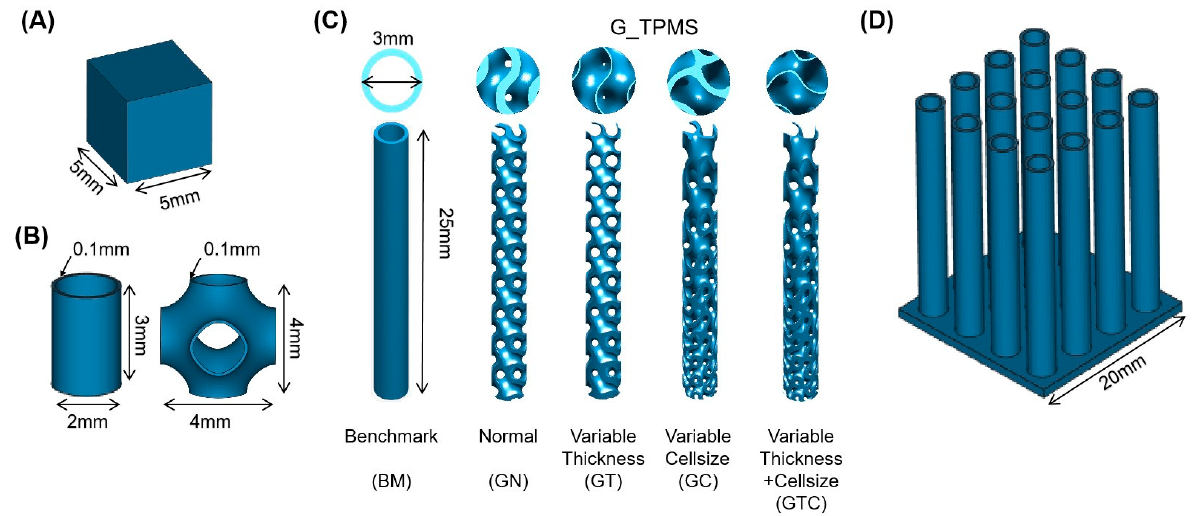
Figure 1. Design models: ( A ) 5 × 5 × 5 mm 3 cube for energy density parameter optimization; ( B ) 0.1 mm wall-thickness cylinder and 0.1 mm wall-thickness of P-type TPMS samples for parameters optimization of TWS; ( C ) Different sample design with BM/GN/GT/GC/GTC structures; ( D ) Pseudoheatsink example design.